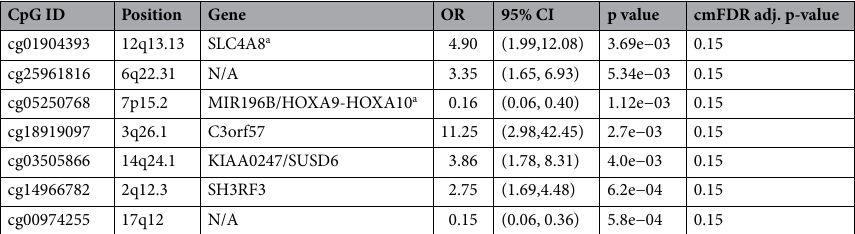
Table 3. The seven CpG sites rejected at FDR level of 0.15 with AdaPT (covariate modulated FDR; cmFDR). p value from the conditional logistic regression analyses and cmFDR adjusted with AdaPT using log p-values from the GSE120878 analysis. Adjusted for lifetime number of sunburns, hair colour, and the 10 first surrogate variables. OR odds ratio, CI confidence interval, FDR False discovery rate, cmFDR covariate modulated FDR. a GRCh37/hg19 (nearest